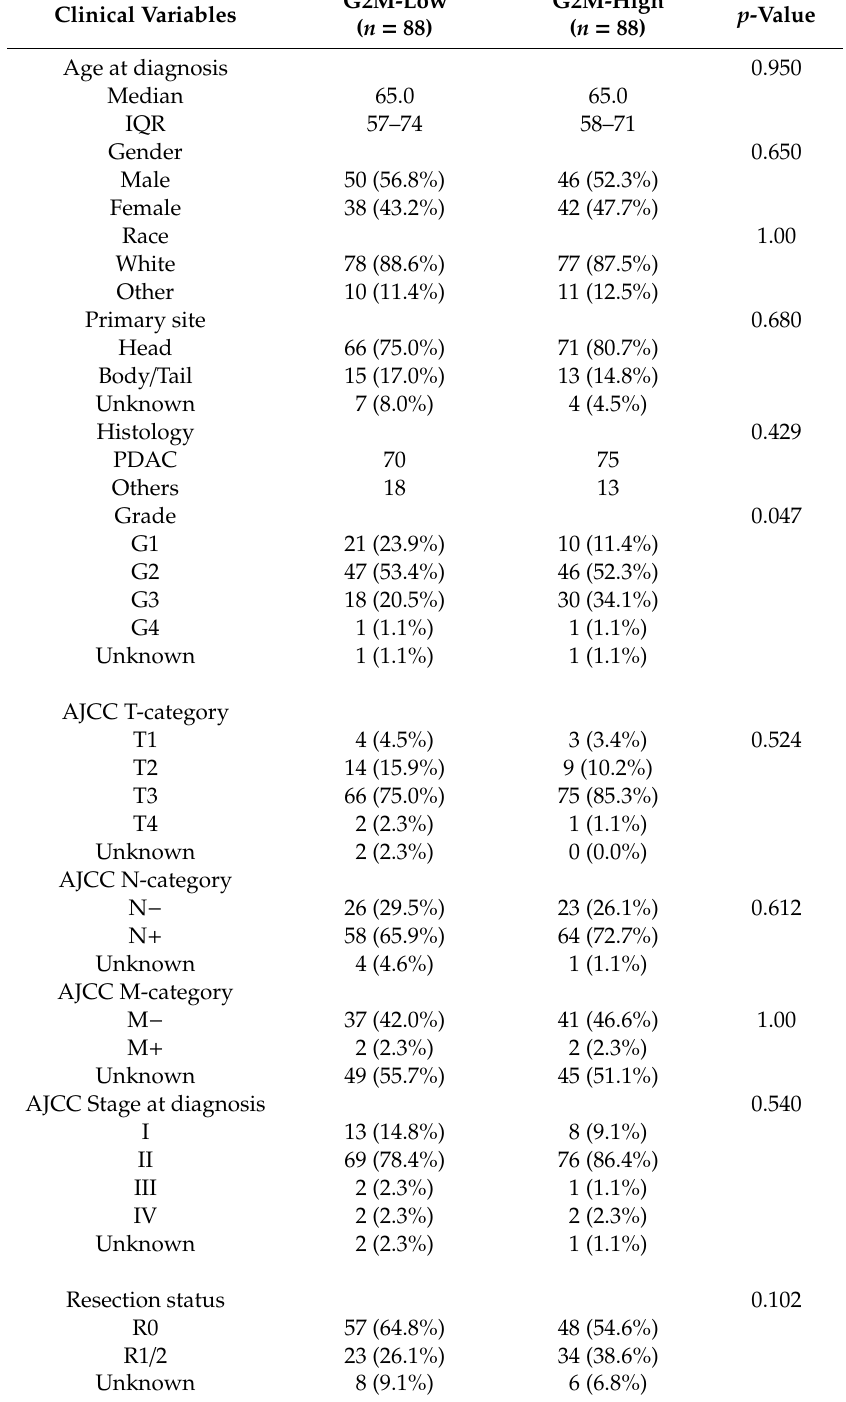
Table 1. Clinical characteristics of the low and high G2M score pancreatic cancer patients in The Cancer Genome Atlas (TCGA)